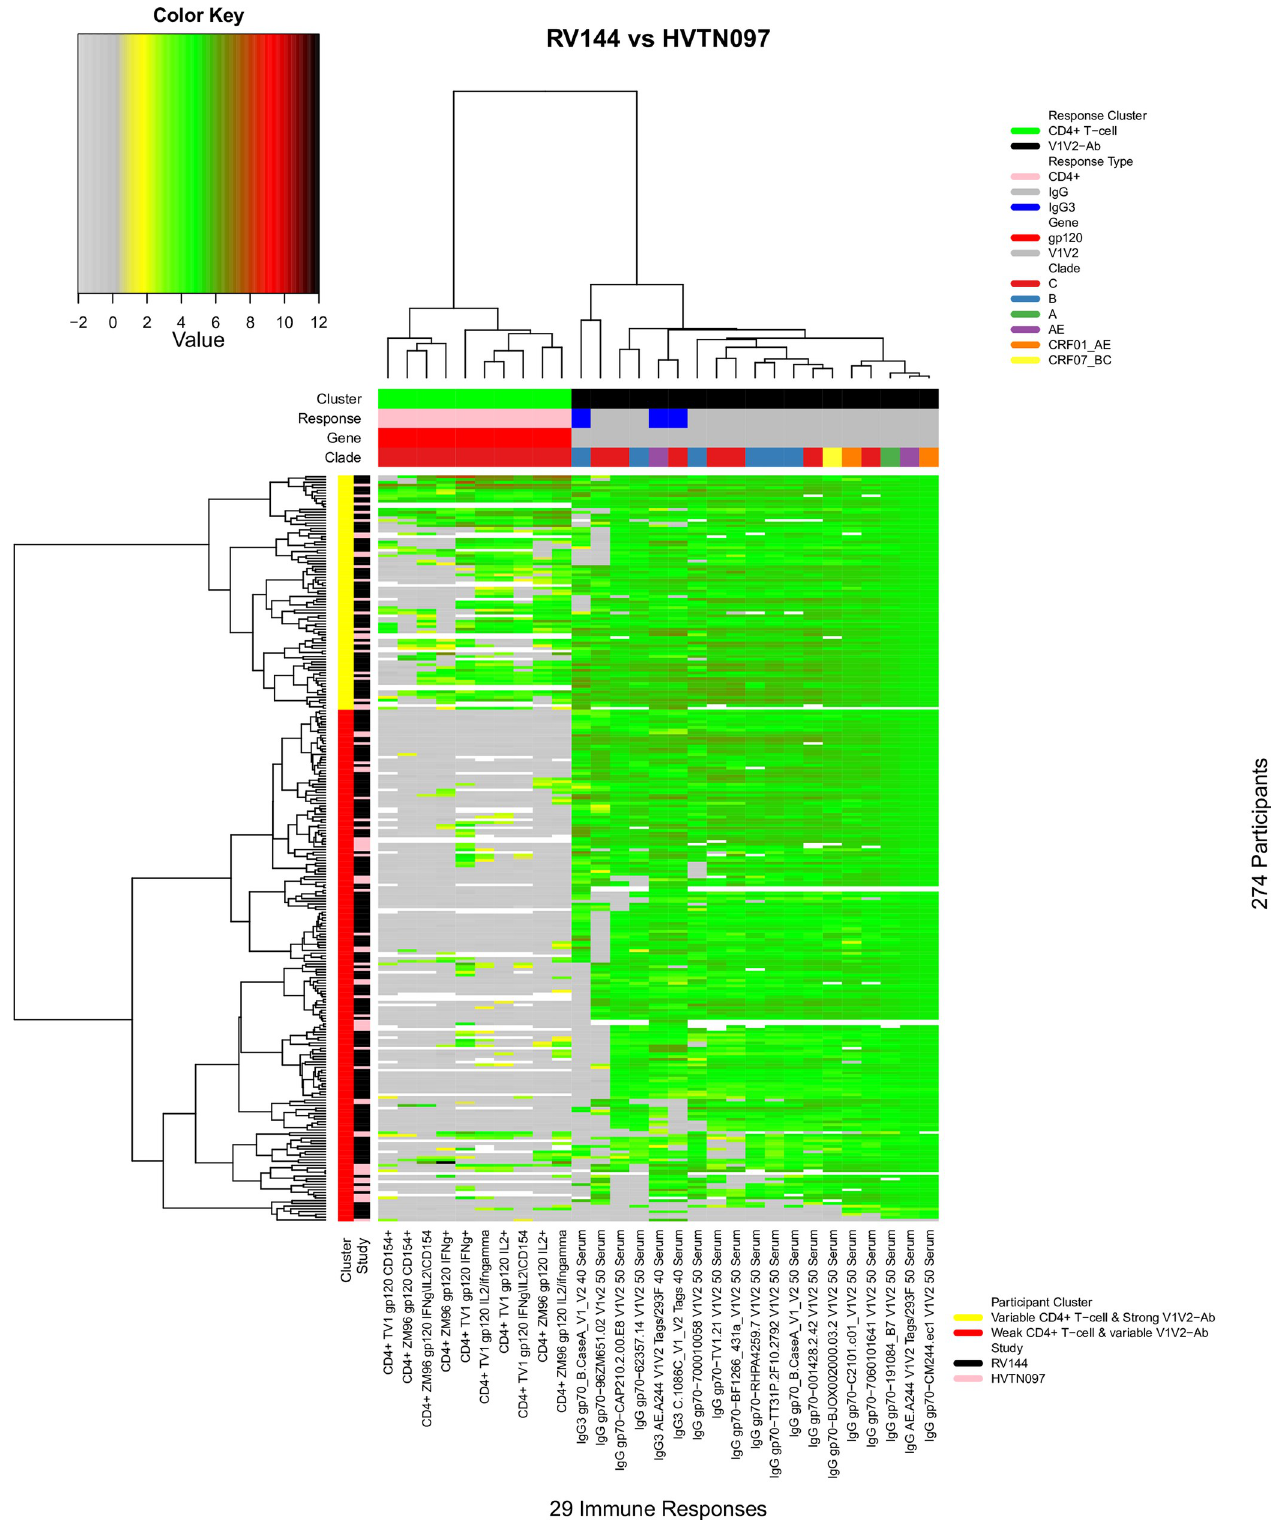
Fig 3. Landscape of immune responses in Thai and South African populations to the P AE/B /alum regimen. The heatmap shows 29 selected immune response measurements of RV144 and HVTN 097 vaccine recipients. Columns designate immune responses; cluster, response, gene, and clade information are